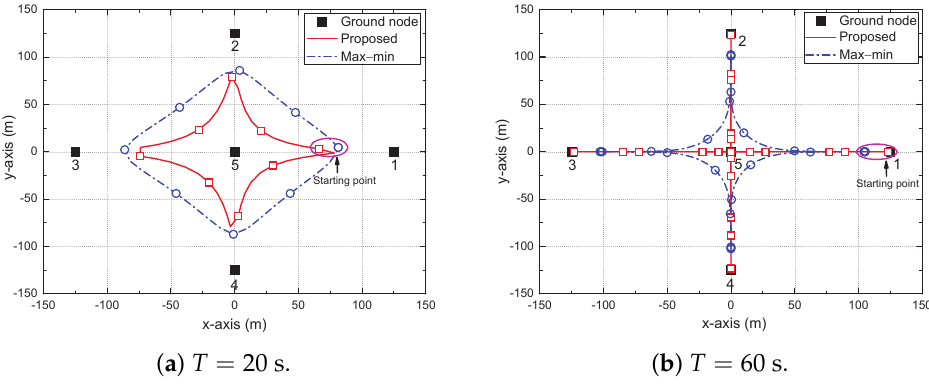
Figure 3. Trajectory of UAV for different T .